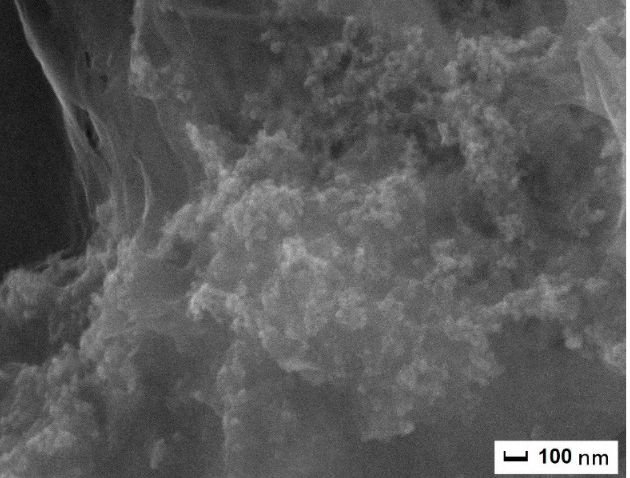
Figure 4. Typical SEM images for the chemically cleaned sample. The NDs are clearly visible in agglomerated form and the graphite is virtually absent.